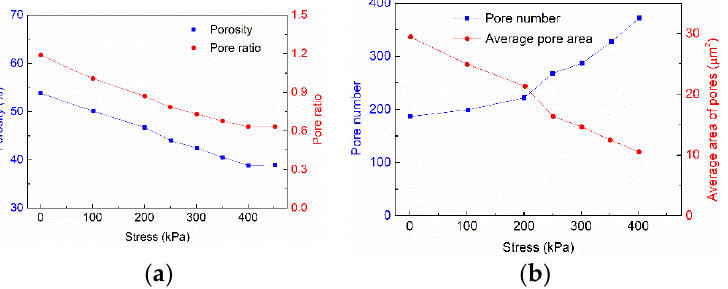
Figure 4. Stress-dependent pore characteristics of soft marine soil: ( a ) porosity and pore ratio; ( b ) pore number and average area of pores.